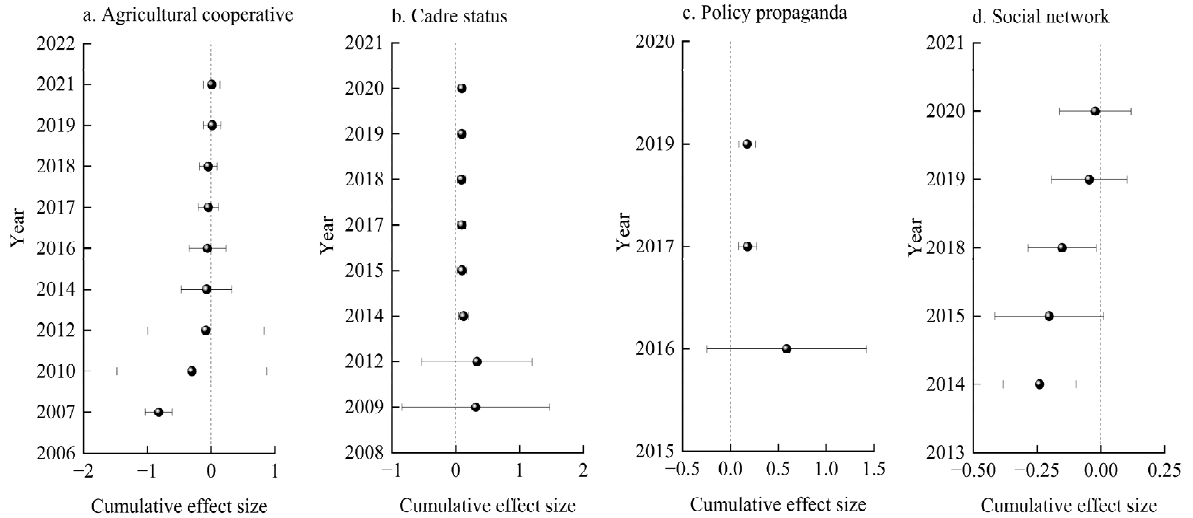
Figure 5. Cumulative meta-analysis trend (cognitive characteristics).